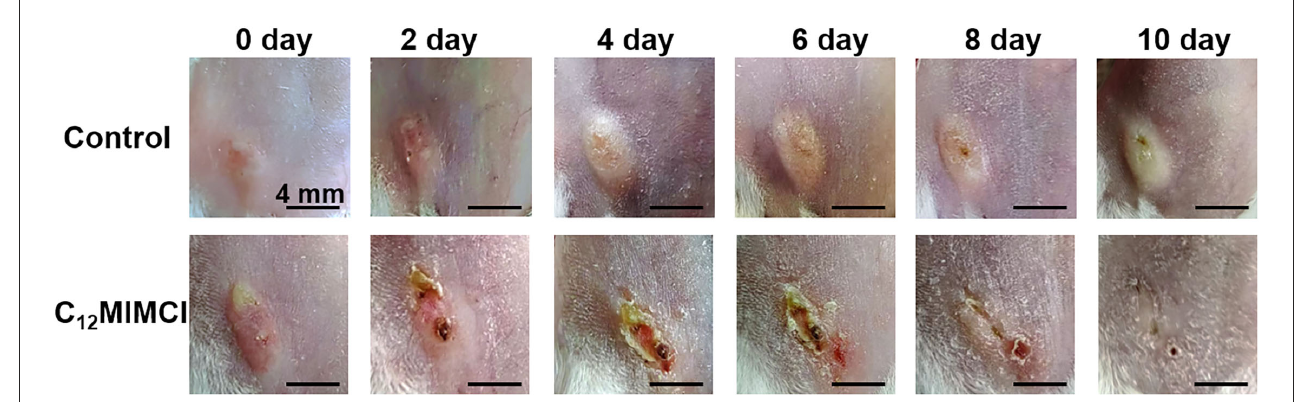
FIGURE8 Changes of skin abscess in mice after Staphylococcus aureus infection and C 12 MIMCl treatment.